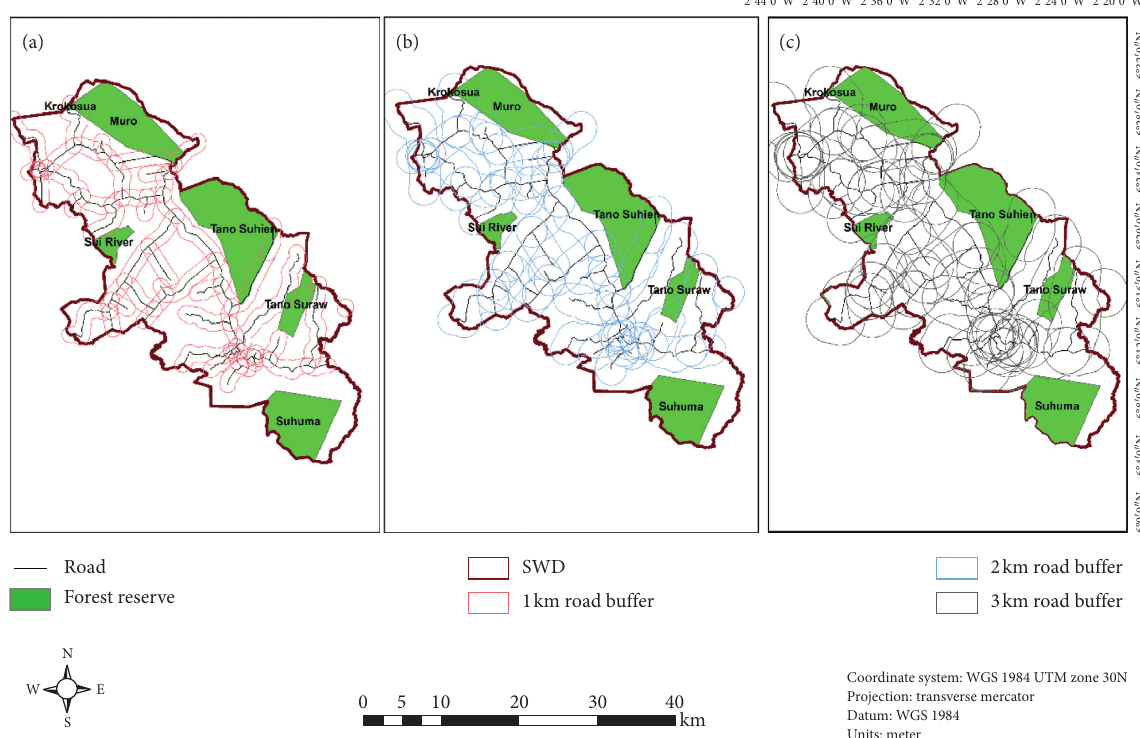
Figure 9: Road buffer overlay on FRs in SWD: (a) 1 km; (b) 2km; and (c)